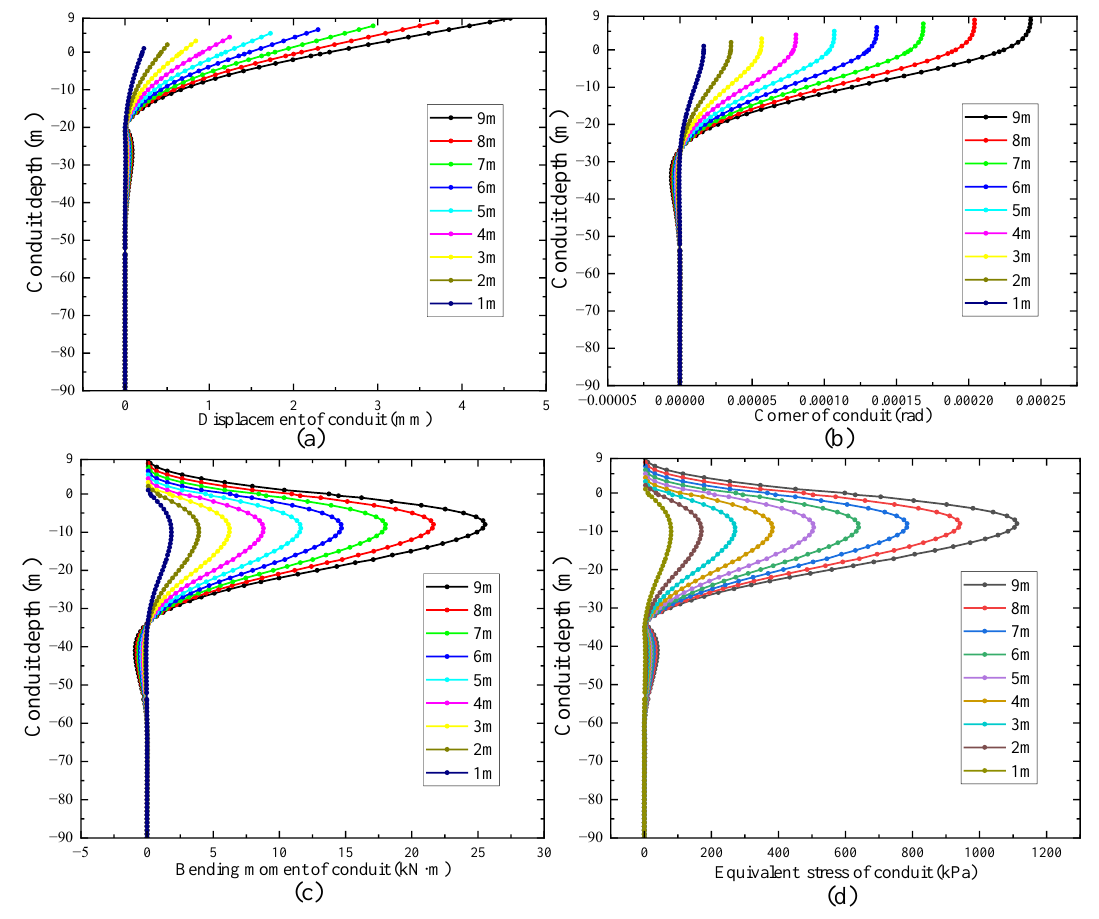
Figure 8. ( a ) Effect of conductor wellhead height on conductor displacement, ( b ) Effect of conductor wellhead height on conductor turning angle, ( c ) Effect of conductor wellhead height on conductor bending moment, ( d ) Effect of conductor wellhead height on conductor equivalent force.